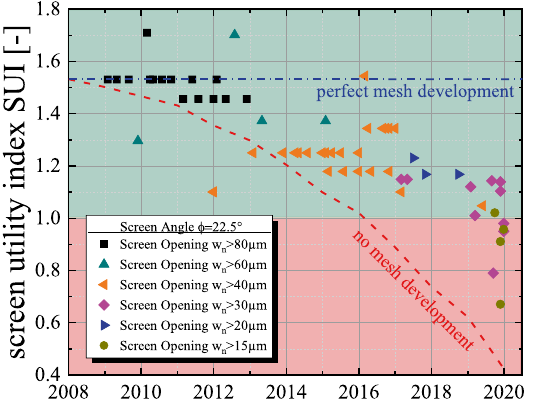
Figure 5. History of screen printing experiments at Fraunhofer ISE using screens with the shown screen utility indices SUI. The progression towards smaller SUI values shows the natural evolution of the fine line screen printing process for metallization of Si-solar cells. The nominal screen opening width was continuously reduced over the years. The development of finer mesh patterns was not able to keep up with this trend, resulting in an average SUI reduction of approx. 0.05 points per year. In 2019, Fraunhofer ISE has challenged the screen printing process with an intense reduction of screen opening structures down to 15